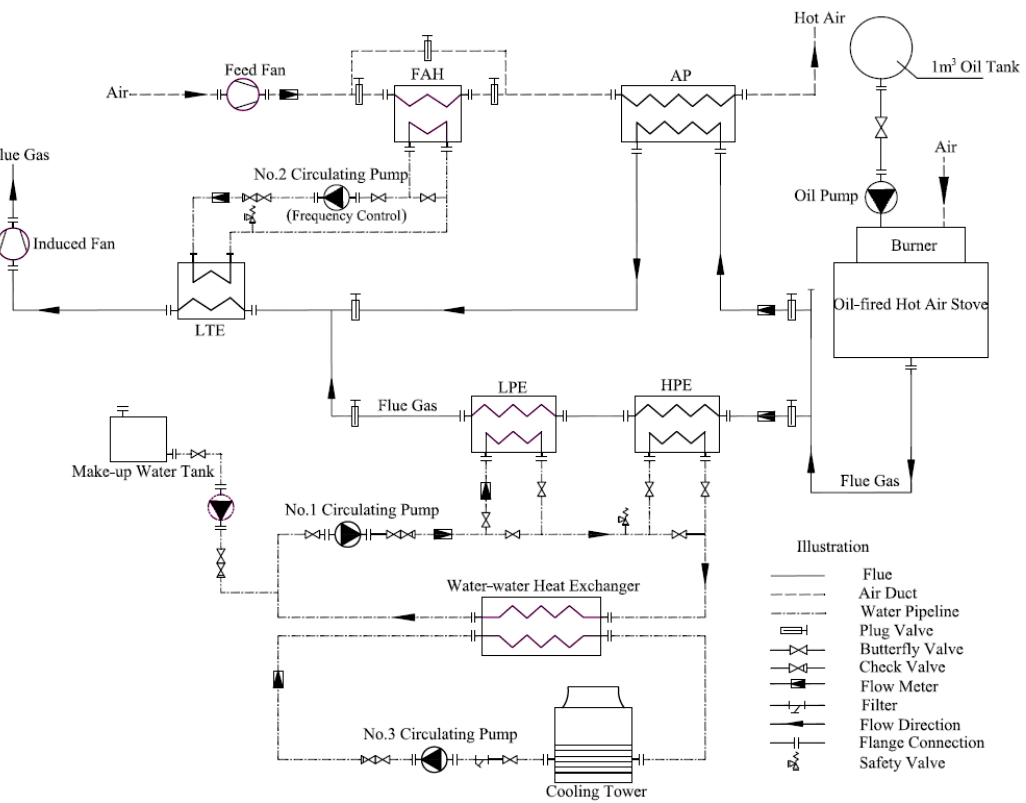
Figure 6. Technical process of experiment equipment. AP: Air Preheater; FAH: Front located Air Heater; LTE: Low Temperature Economizer; LPE: Low Pressure Economizer; HPE: High Pressure Economizer. The main designed parameters of the experimental equipment are indicated in Table 1. Table 1. Main designed parameters of the experimental equipment.